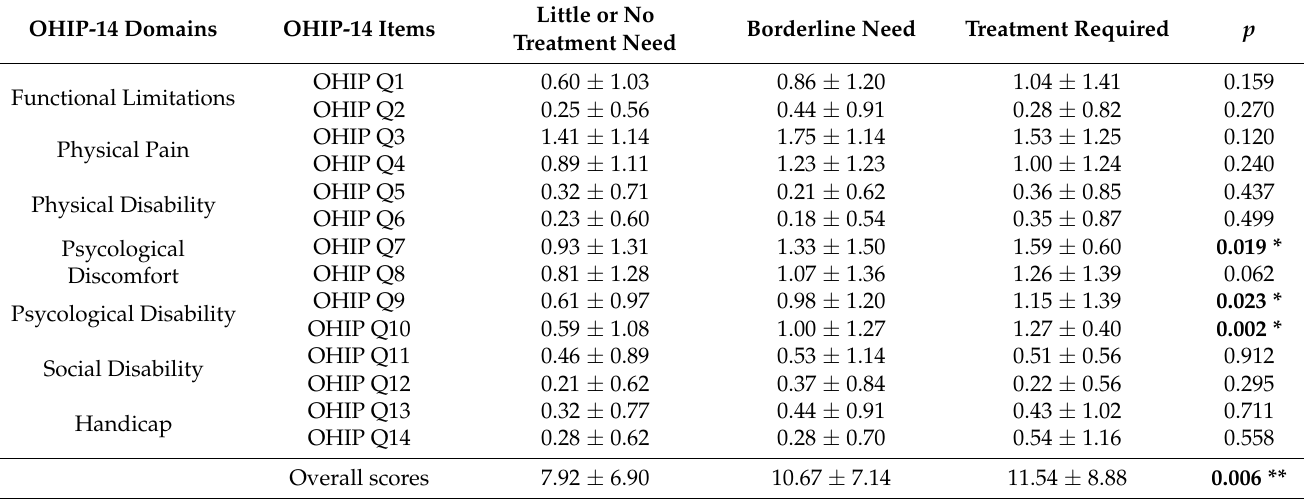
Table 5. Mean ± SD overall OHIP-14 score among different types of IOTN-DHC